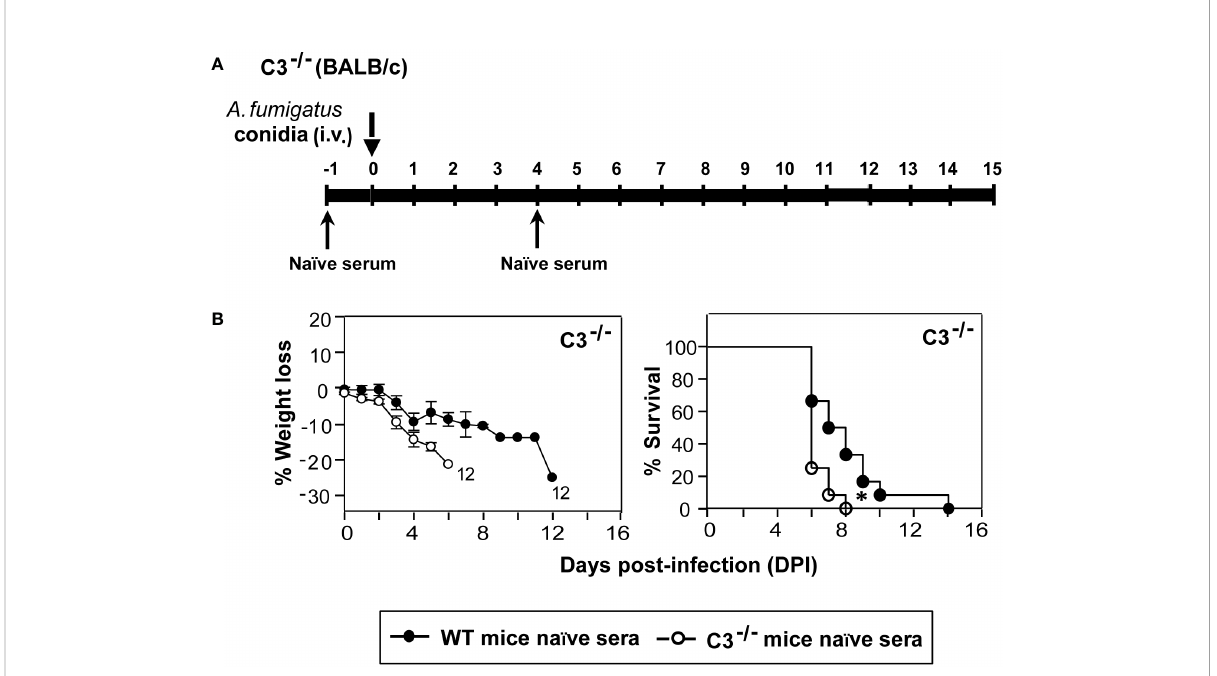
FIGURE 6 Natural antibodies aid in protection against systemic A fumigatus infection. (A) Diagrammatic depiction of the experimental setup. C3 -/- mice received 250 µl serum (i.p.) of naïve heat-inactivated sera from WT (BALB/c) or C3 de fi cient (C3 -/- ; BALB/c) at day -1 and day 4. These mice were challenged intravenously with 1x10 5 conidia on day 0 and observed for body weight loss and mortality till the end of the experiment. (B) Body weight loss and survival of the infected complement C3 -/- mice that received heat-inactivated naïve sera either from WT or from C3 -/- mice. Passive transfer of naïve sera from WT mice extended the survival of infected C3 -/- mice (*p < 0.01). Results shown are mean ± SEM of two independent